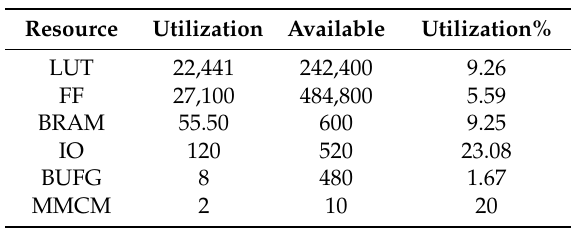
Table 1. Device utilization summary.